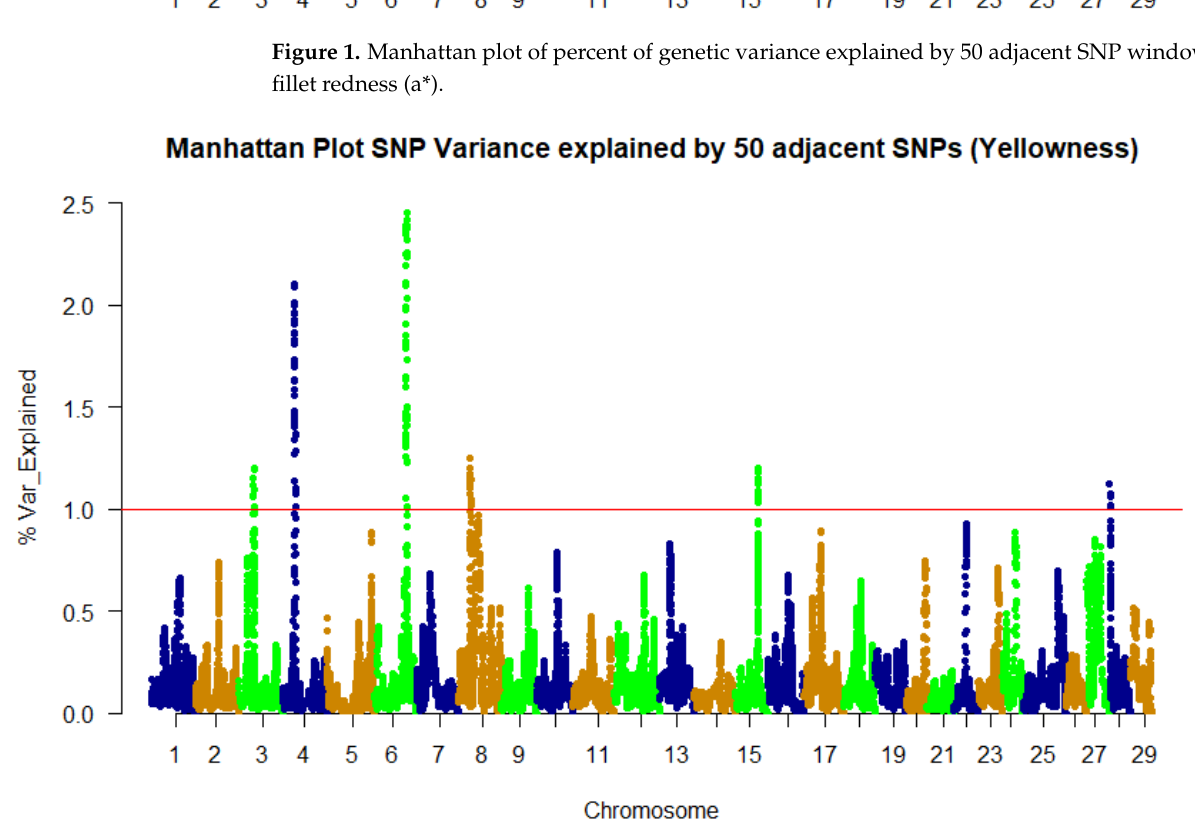
Figure 2. Manhattan plot of percent of genetic variance explained by 50 adjacent SNP windows for fillet yellowness (b*).